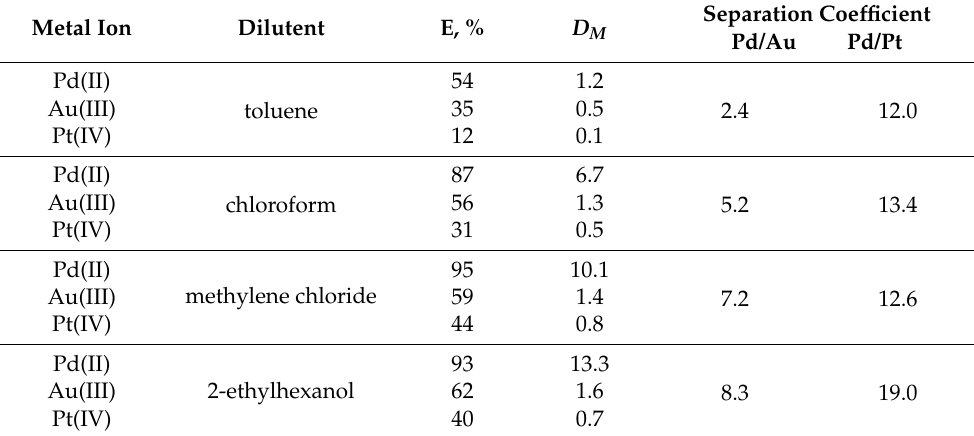
Table 4. Extraction of mixture Au(III), Pd(II), and Pt(IV) with EDAB-acac in different diluents from acidic medium (0.1 M HCl). The initial concentration of each metal ion was 1 mM.